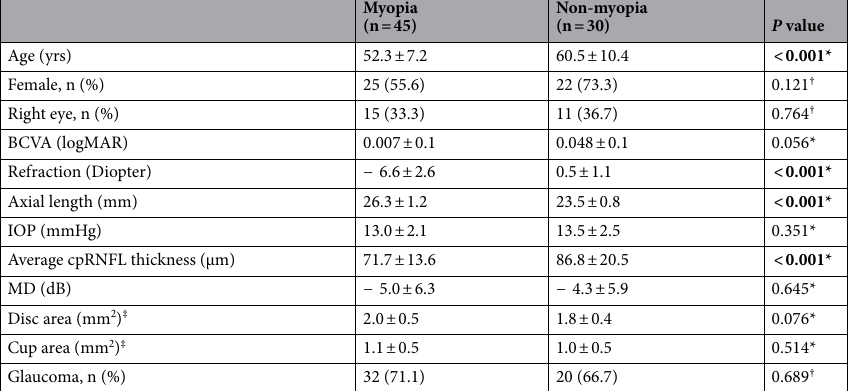
Table 2. Baseline demographics and descriptive characteristics with visible nasal LC. Except where indicated otherwise, values are mean ± standard deviation or number (%). *Comparison was performed using the Student t test. † Comparison was performed using the two proportion z-test. ‡ Corrected area calculated in consideration of the magnification factors related to the SD-OCT camera and the eye by substituting the subject’s axial length. Statistically significant values are shown in bold ( P < 0.05). BCVA: best-corrected visual acuity; cpRNFL: circumpapillary retinal nerve fiber layer; IOP: intraocular pressure; LC: lamina cribrosa; MD: mean deviation.